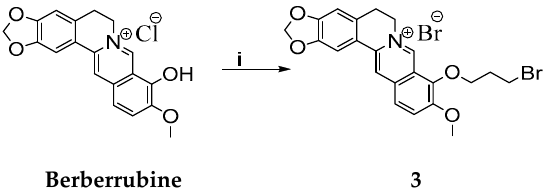
Scheme 2. Synthesis of berberine derivative 1 and derivative 2 . Reagents and conditions: (i) CH 3